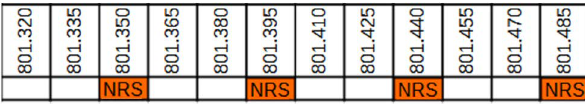
Figure 7. Subcarriers and NRS position.